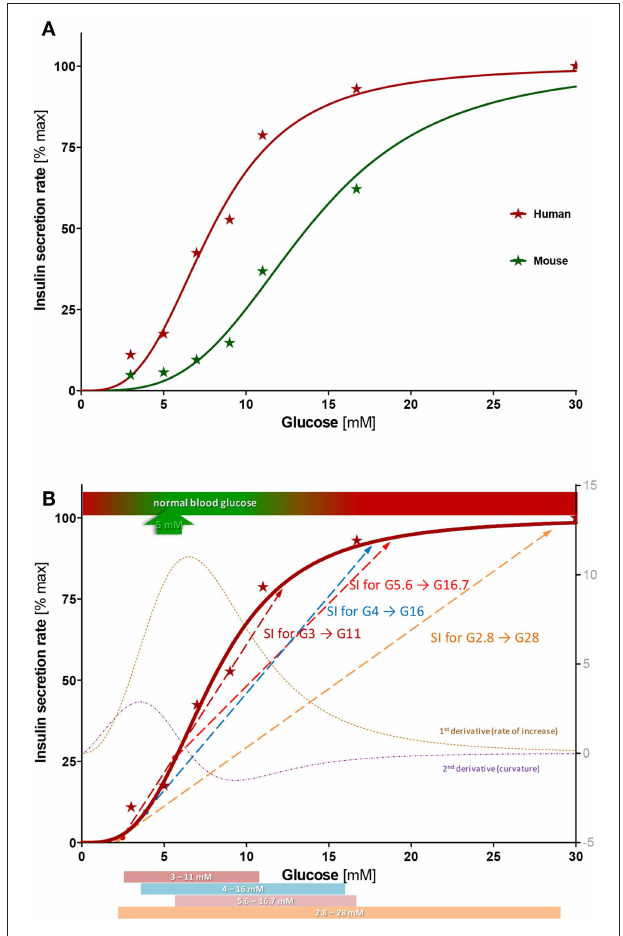
FIGURE 5 | Concentration-response of insulin secretion. (A) Average insulin secretion rate (first- and second phase) at different glucose steps expressed as percent of maximum value (at G30) and fitted with a sigmoidal dose response function (Hill function, Equation 1). Compared to human islets, mouse islets have a similar Hill slope ( n = 3.4 ± 0.4 vs. 3.2 ± 0.4), but a right-shifted response (half-maximal concentration C 50 = 13.7 ± 0.6 vs. 7.9